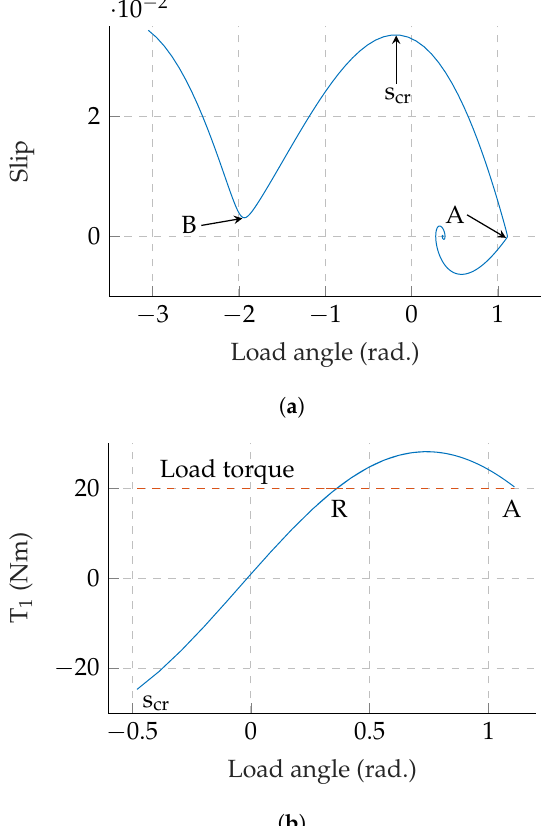
Figure 2. Trend of slip and alternating torque versa load angle during the synchronization process: ( a ) sine-like trend during the last pole slip (from point B to A) and ( b ) approximate corresponding alternating